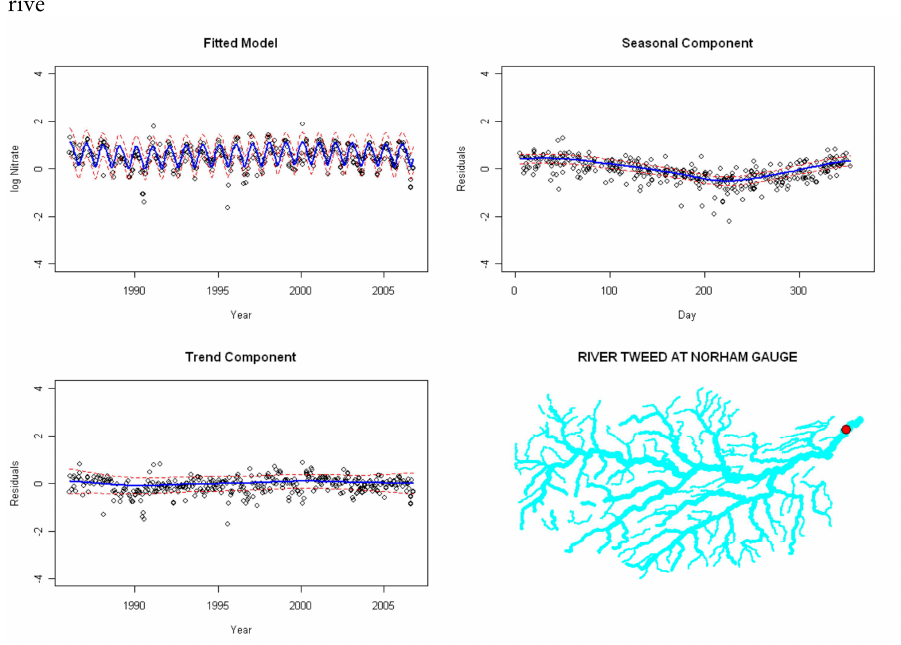
Figure 2 – Group Fitted additive model to the time series from a single site, but where the model has used a river distance covariance model (O’Donnell,